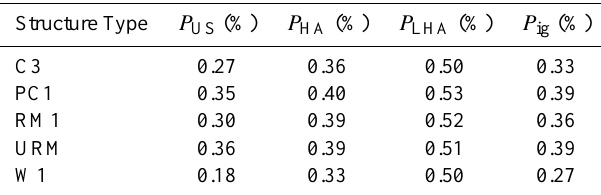
Table 8. Results of post-earthquake ignition analysis for the build- ings.